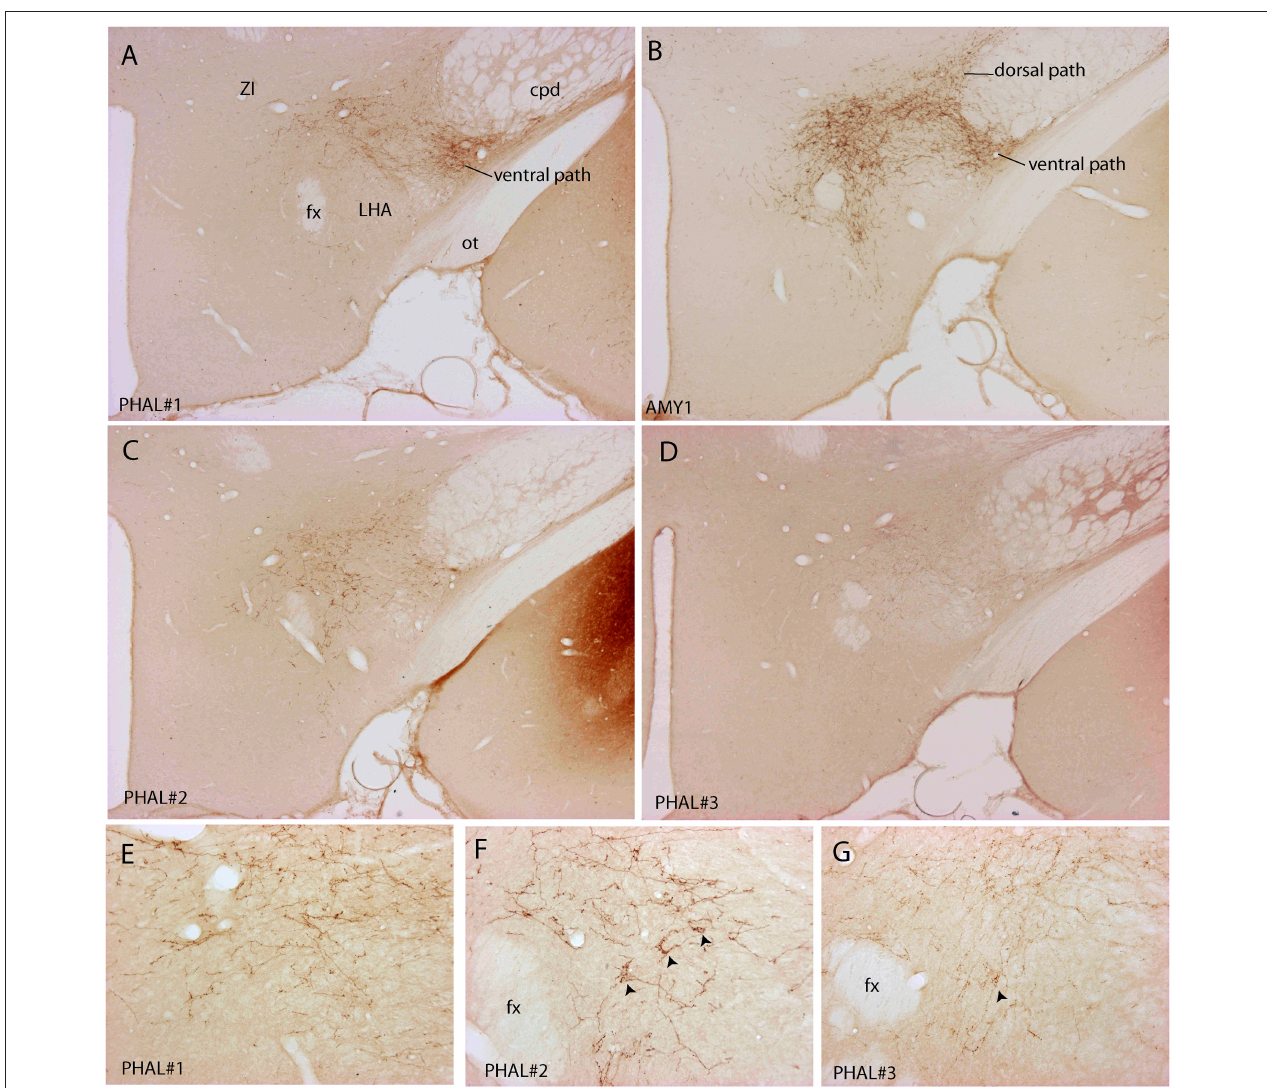
FIGURE 3 | Photomicrographs illustrating the distribution of PHAL axons in the rostral tuberal LHA of the four experiments PHAL#1, AMY1, PHAL#2, and PHAL#4. (A–D) Low magnification pictures. Note in A (PHAL#1) that only the ventral pathway is labeled, but axons innervate dorsal LHA regions. By comparison, the dorsal and ventral pathways are clear in the experiment AMY1. Injections in experiments PHAL#2 and #3 resulted in smaller sites and the number of axons is lower than in the two other cases. In the latter (D) axons are also thinner and more difficult to see at this magnification. (E–G) Higher magnification pictures to illustrate aspects of axons in the experiments PHAL#1, #2, and #3. Note the clear pericellular nets (arrowheads) in the lateral perifornical region of experiment PHAL#2, and even one in PHAL#3. Such figures could not be seen in the experiment PHAL#1. In this last experiment, axons displayed less collaterals and buttons. Therefore, even if the axons were very well labeled, this was interpreted as a weaker innervation of the LHA that than in the other